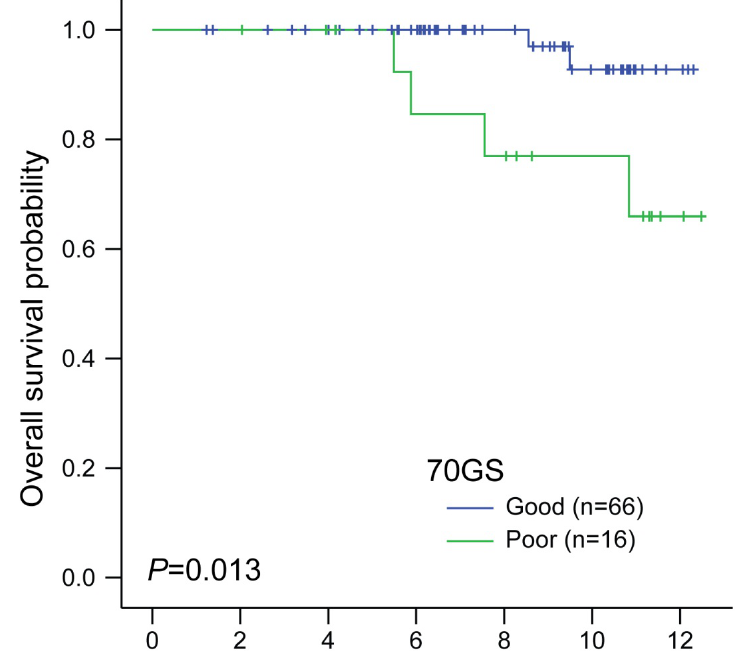
Figure 2. Kaplan-Meier plots for OS according to 70GS predictor in ER-positive patients with intermediate RSs ( p = 0.013, log-rank